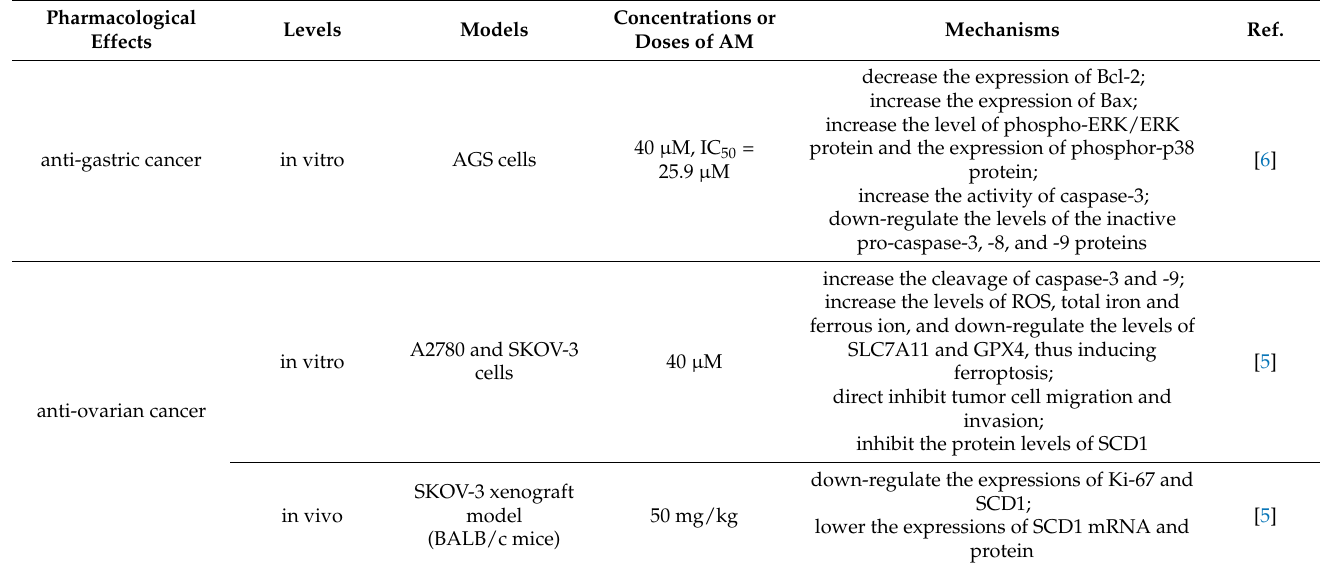
Table 4. Mechanisms of pharmacological effects of